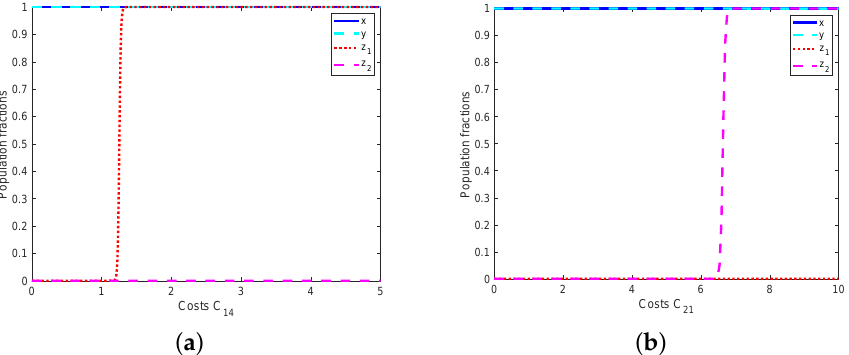
Figure 7. Impact of cyberattack costs on the ESS E 6 . ( a ) Evolution of population fractions x , y , z 1 , and z 2 over C 14 . ( b ) Evolution of population fractions x , y , z 1 , and z 2 over C 21